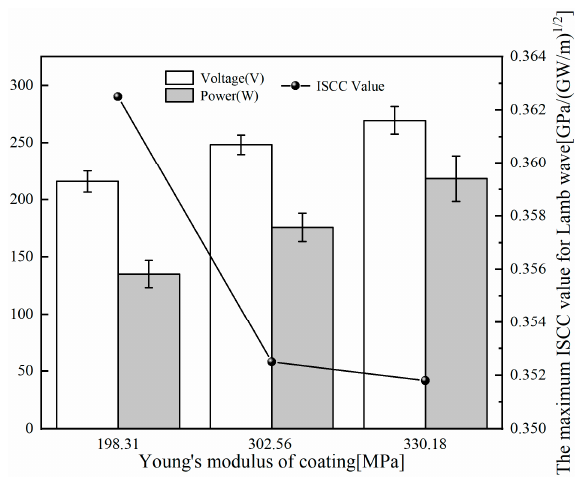
Figure15. De-icingvoltage, power, andthemaximumISCCvalueforcoatingswithdi ff Figure 15. De-icing voltage, power, and the maximum ISCC value for coatings with different Young’s moduli .